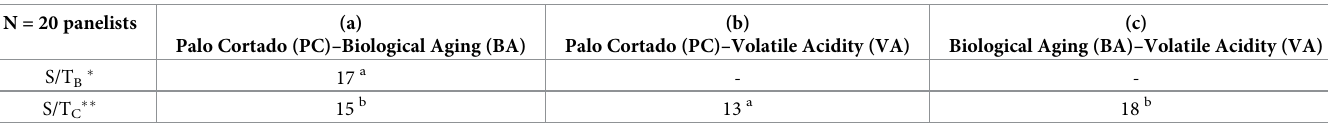
N = number of panelists that differentiate wine classes by applying UNE EN ISO standards. a,b Superscript mean confidence level ( α risk) in the wines: a α �